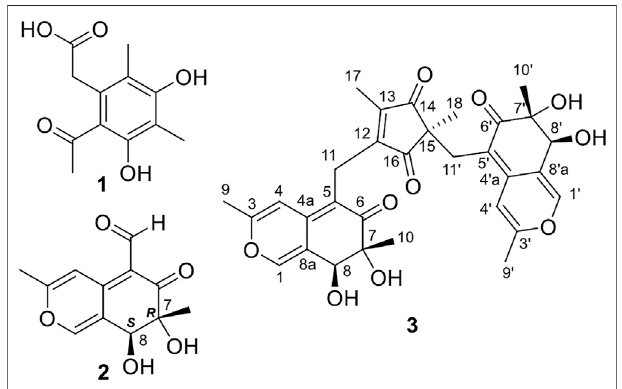
FIGURE 1 | The structures of compounds 1 - 3 .